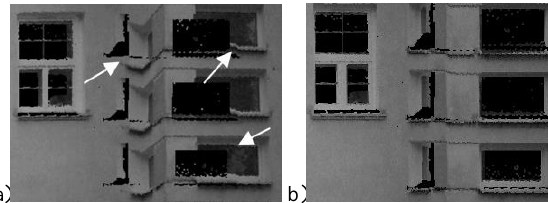
Figure 4. Texturing errors using the NIR image: 1) uneven distribution of points b) even distribution of